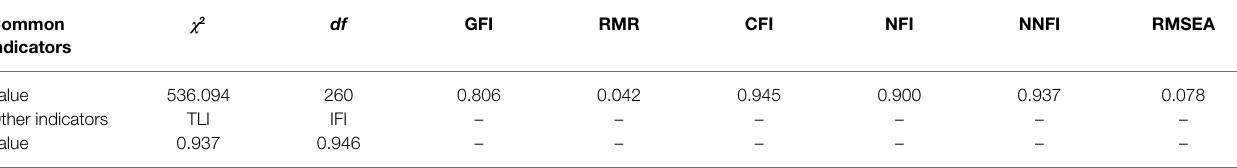
TABLE 3 | Confirmatory factor analysis.